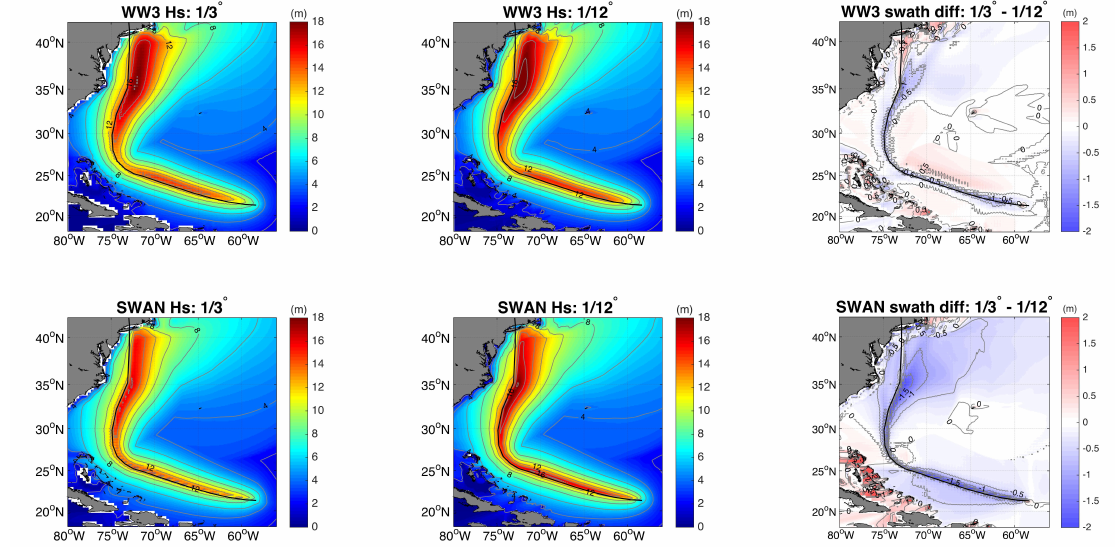
Figure 12. Comparison of swath of maximum SWH: in a 1/3 ◦ simulation ( left column ); and in a 1/12 ◦ simulation ( center column ); and their difference ( right column ), under Hurricane 1938. ( top row ) WW3 results; and ( bottom row ) SWAN results. Hurricane track is denoted by the black solid line. Contour increment for swath is 3 m. Contour increment for swath difference is 0.5